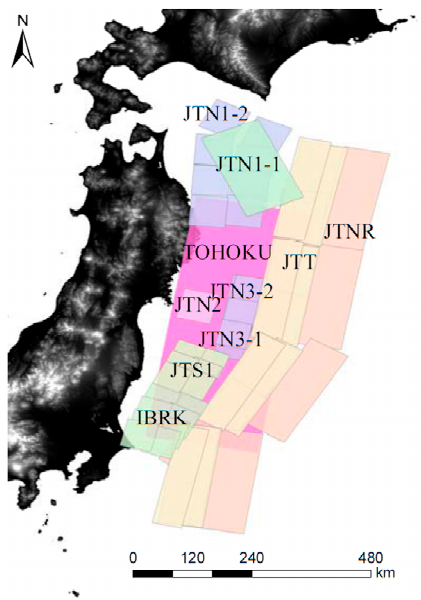
Figure 4. The selected earthquakes that could generate a tsunami based on the occurrence region of the trench-type earthquake along the Japan Trench, which is used in the probabilistic seismic motion prediction map [14].